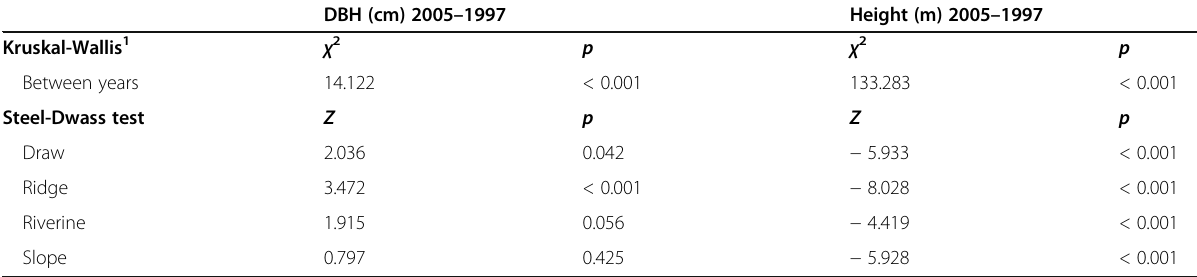
Table 5 Statistical tests comparing forest structural metrics between years